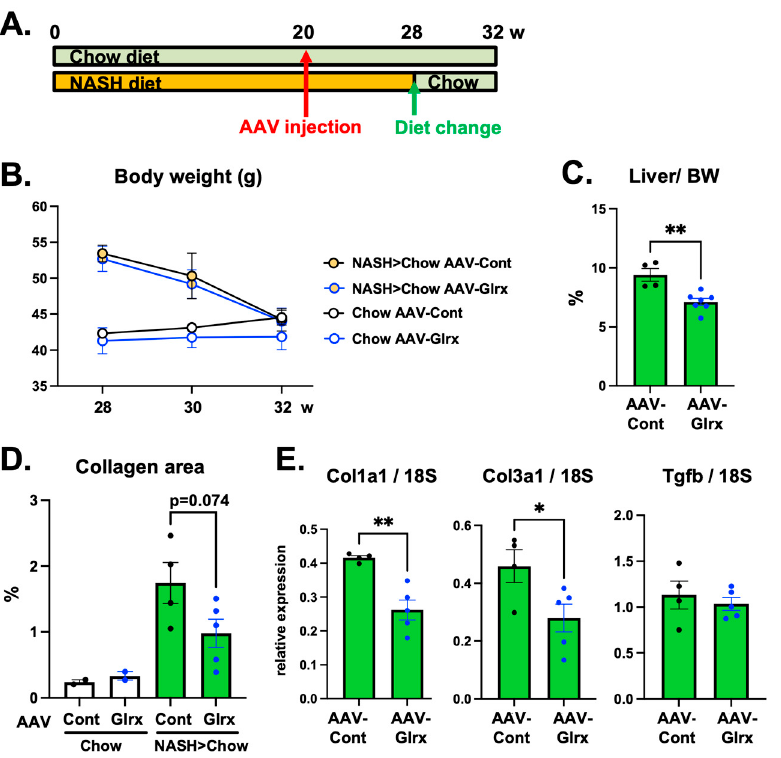
Figure 6. AAV-Hep-Glrx has a supplemental anti-fibrotic effect on diet modification. ( A ). Experimental design. AAV-Hep-Glrx or AAV-Hep-control was injected into mice fed chow or NASH diet (20 weeks). After 28 weeks NASH diet, a cohort was switched to regular chow for four more weeks. ( B ). Time course of bodyweight of each group after changing to chow diet. ( C ). Liver weight as a percentage of bodyweight showing the effect of AAV-Hep-Glrx. ( D ). Collagen staining area (%) by Picro Sirius Red staining. ( E ). Gene expression of fibrotic markers of the liver after dietary modification ( n = 4–5). Blue dots on the graph indicate mice treated with AAV-Hep-Glrx. * p < 0.05, ** p < 0.01. Error bars indicate standard